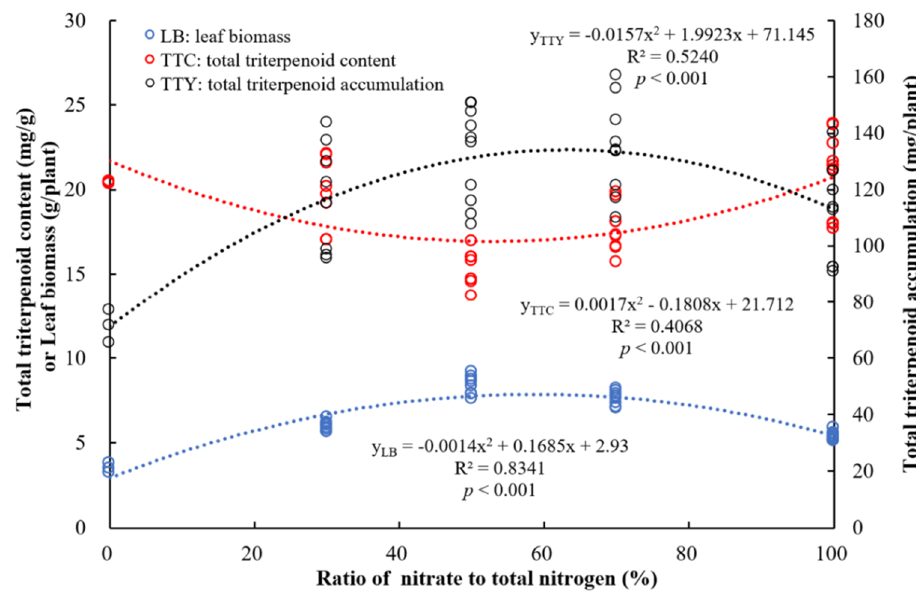
Figure 7. Relationships of total triterpenoid content in the leaves (y TTC ), total leaf triterpenoid accumulation (y TTY ) and leaf biomass (y LB ) per plant to nitrogen forms at the concentration of 238 mg / L (x) across the sampling times ( n = 39). All C. paliurus seedlings had died at 52 days after the treatment in T5.